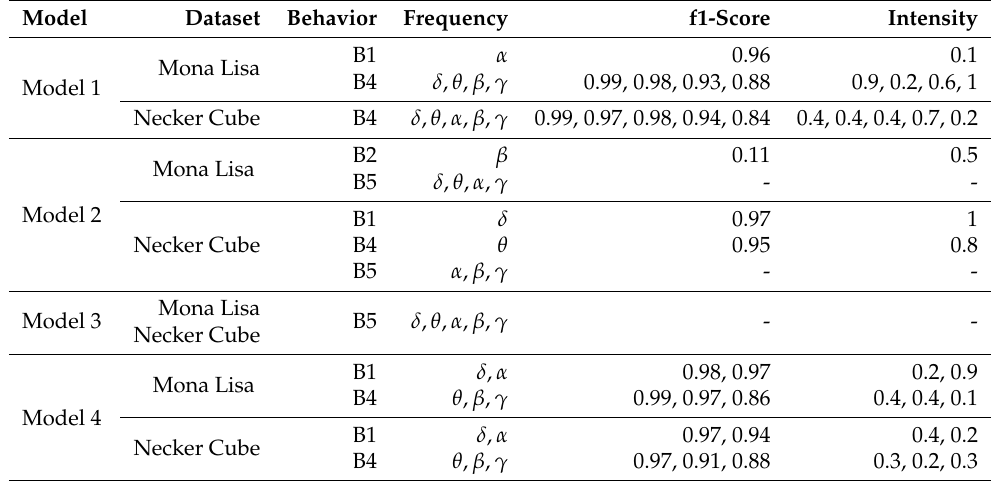
Table 9. The results of using the models with Nadam optimizer for intensity classification. Model